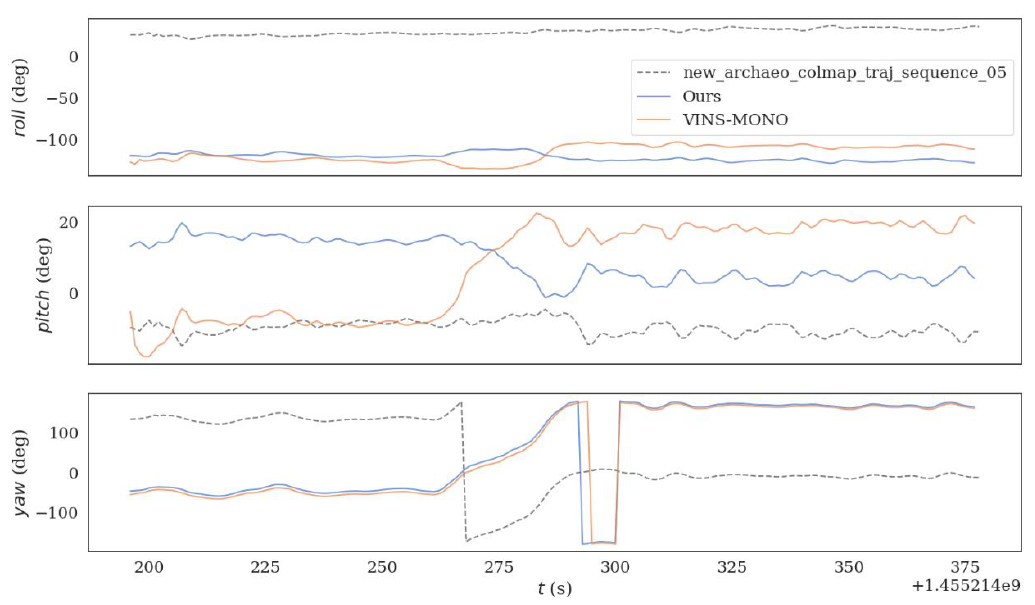
Figure 11. The figure shows the rotation error comparison between the original algorithm and the improved algorithm sequence_05.bag datasets.